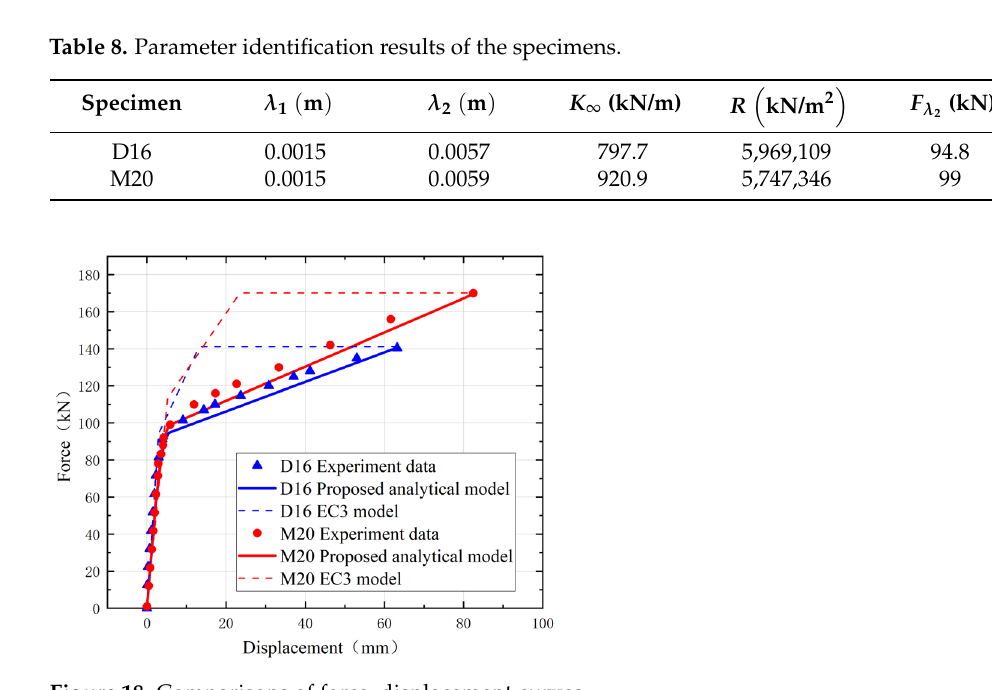
Figure 18. Comparisons of force–displacement curves.